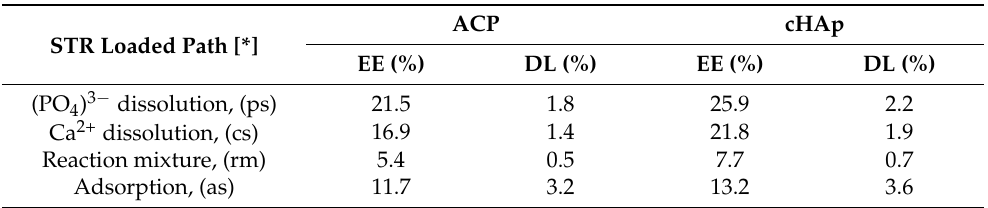
Table 1. Streptomycin (STR)-loaded in ACP and cHAp nanoparticles using different loading routes during their synthesis. [*] indicates the loading path of the drug in the nanoparticle. ACP STR Loaded Path [*]